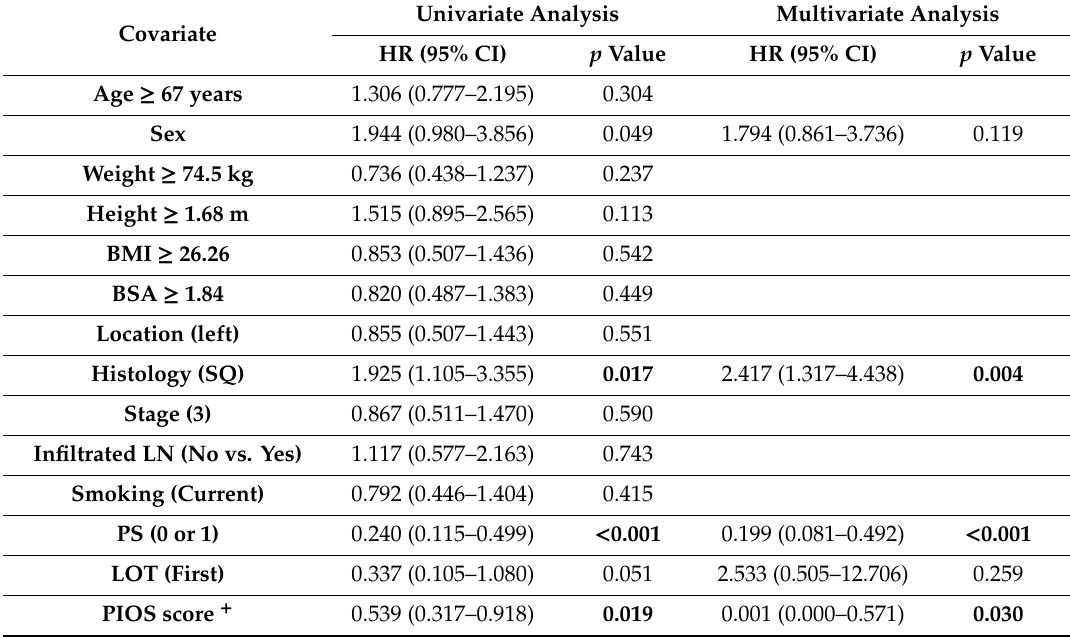
Table 3. Univariate and multivariate analysis for